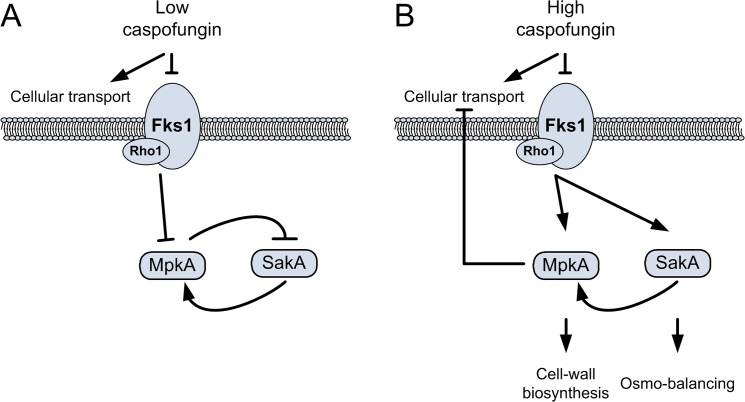
Effects of different caspofungin concentrations on MAPK cascades.(A) When caspofungin is used at inhibitory concentrations (1 μg ml-1), a repression of MpkA and SakA phosphorylation levels is observed. Under these conditions, the cellular transport is stimulated and the inhibition of MpkA and SakA avoids the turn-on of compensatory pathways. (B) The use of caspofungin at higher doses strongly activates MpkA and SakA. Under these conditions, cellular transport is inhibited and cell-wall compensatory pathways are more active.